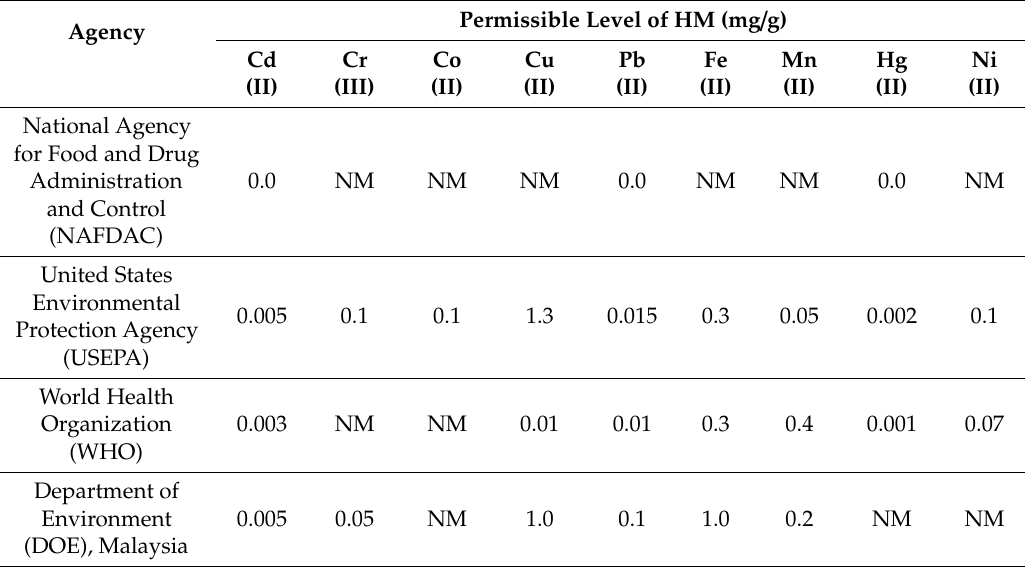
Table 1. Maximum level of heavy metal (HM) content in water samples. Table was reproduced from [6], with permission from EDP Sciences,